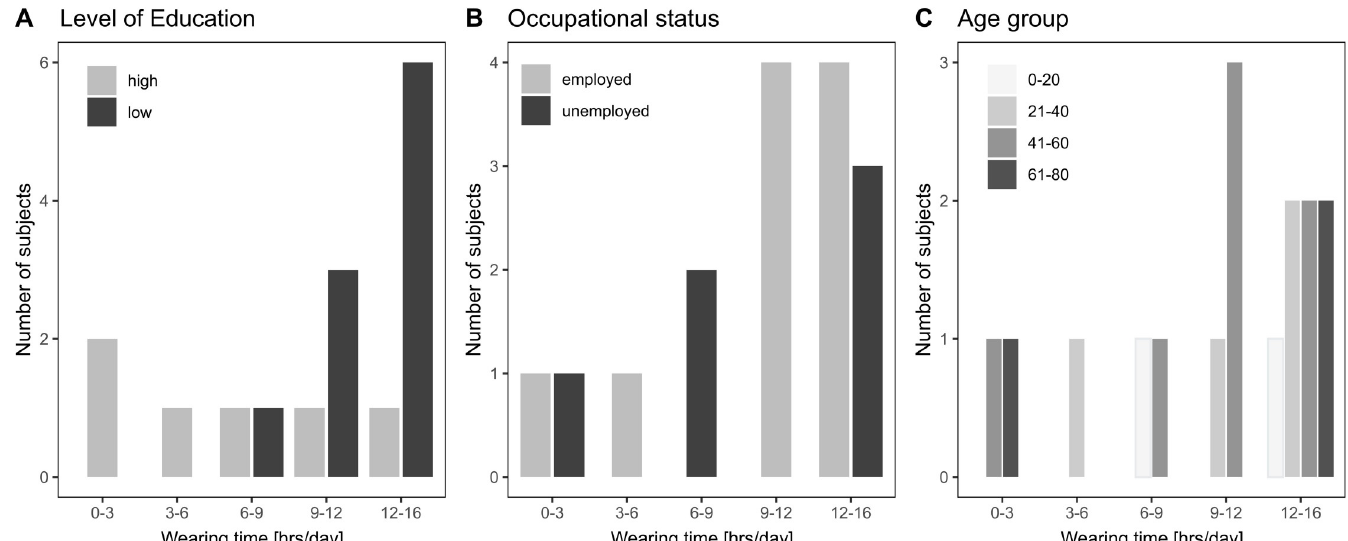
Fig 3. Wearing time. Distribution of wearing time categories as reported by 16 patients, plotted separately by level of education (A), occupational status (B) and age group (C).